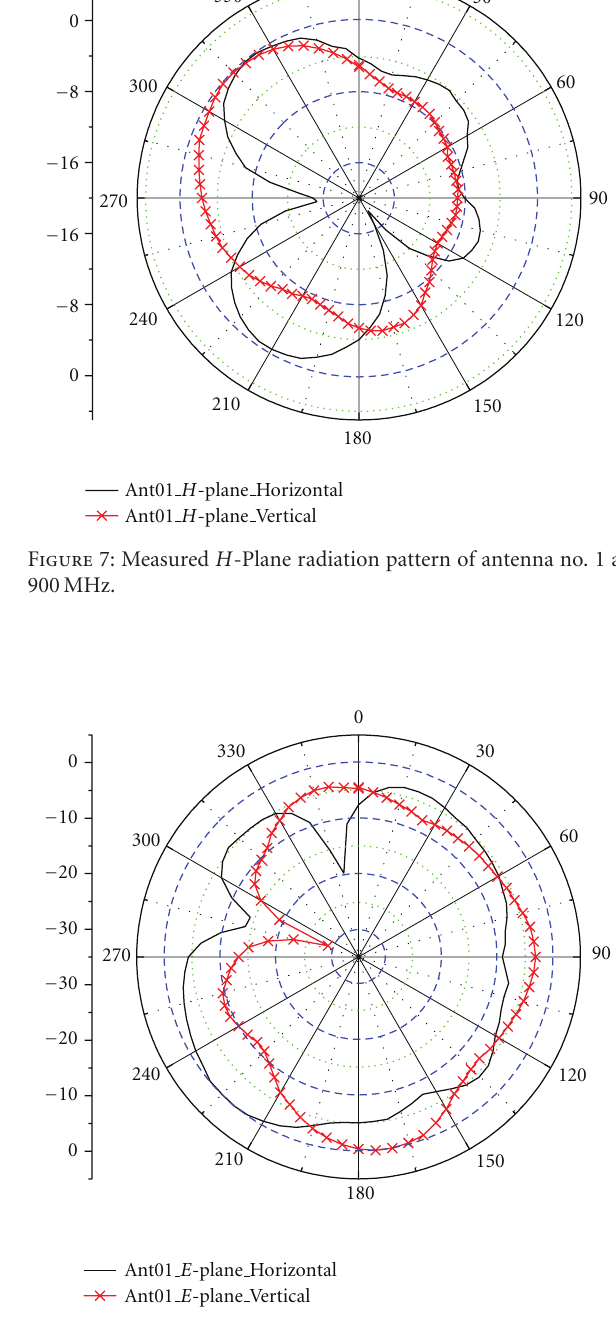
Figure 8: Measured E -Plane radiation pattern of antenna no. 1 at 1900